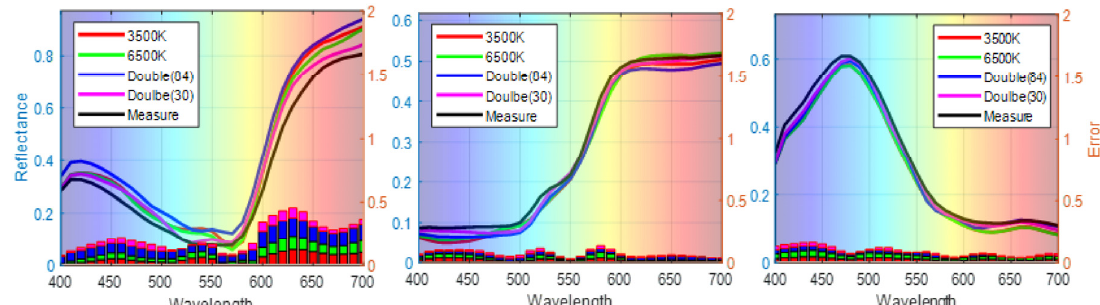
Figure 9. Representative samples of the reconstructed spectra in various